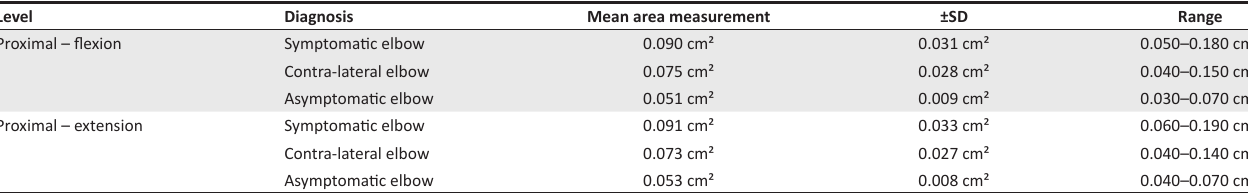
TABLE 3a: Comparison of cross-sectional area measurement of the ulnar nerve, 50 mm proximal to the level of the cubital